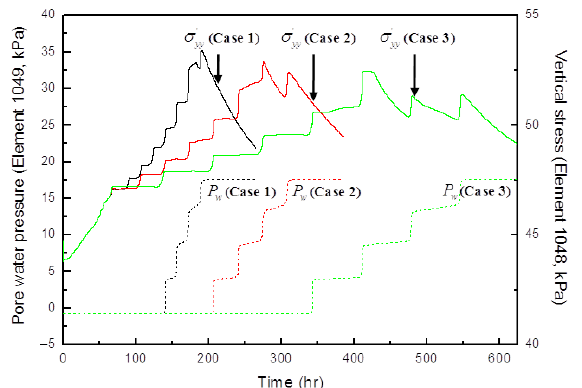
Fig. 18. Stress path (Case 1, at Element 1239)